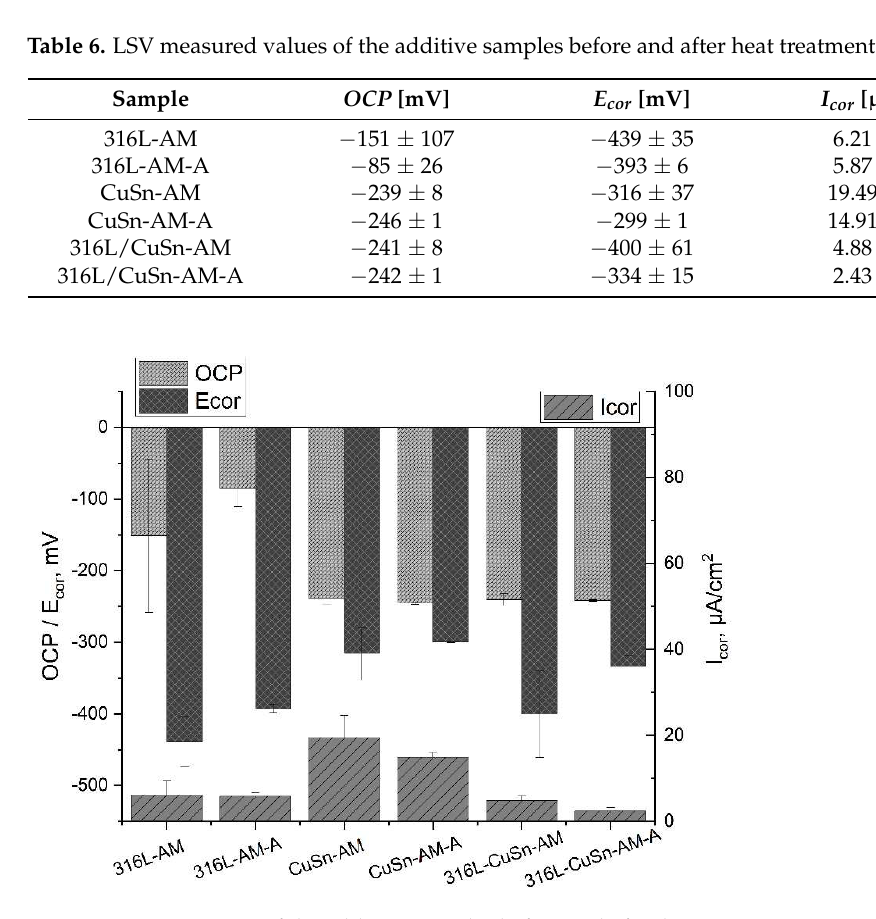
Figure 10. Comparison of the additive samples before and after heat treatment.